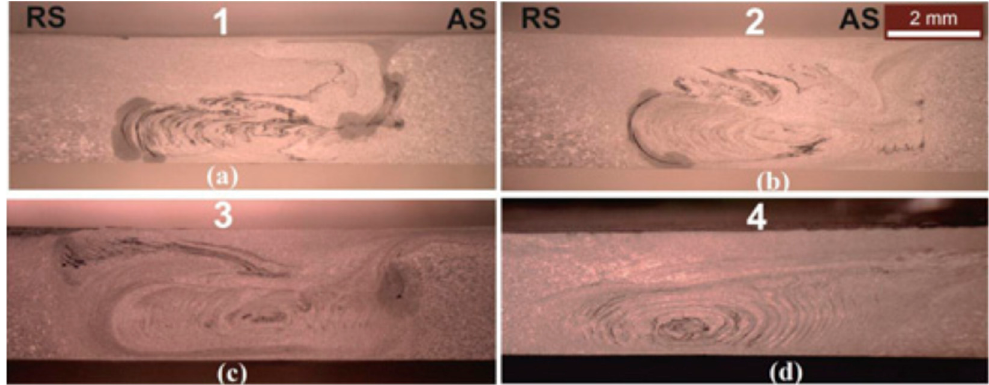
Figure 15. Macroscopic image of weld nuggets ( a ) with 1 pass, ( b ) with 2 passes along the same direction, ( c ) with 3 passes along the same direction and ( d ) with 2 passes in opposite directions [32] .